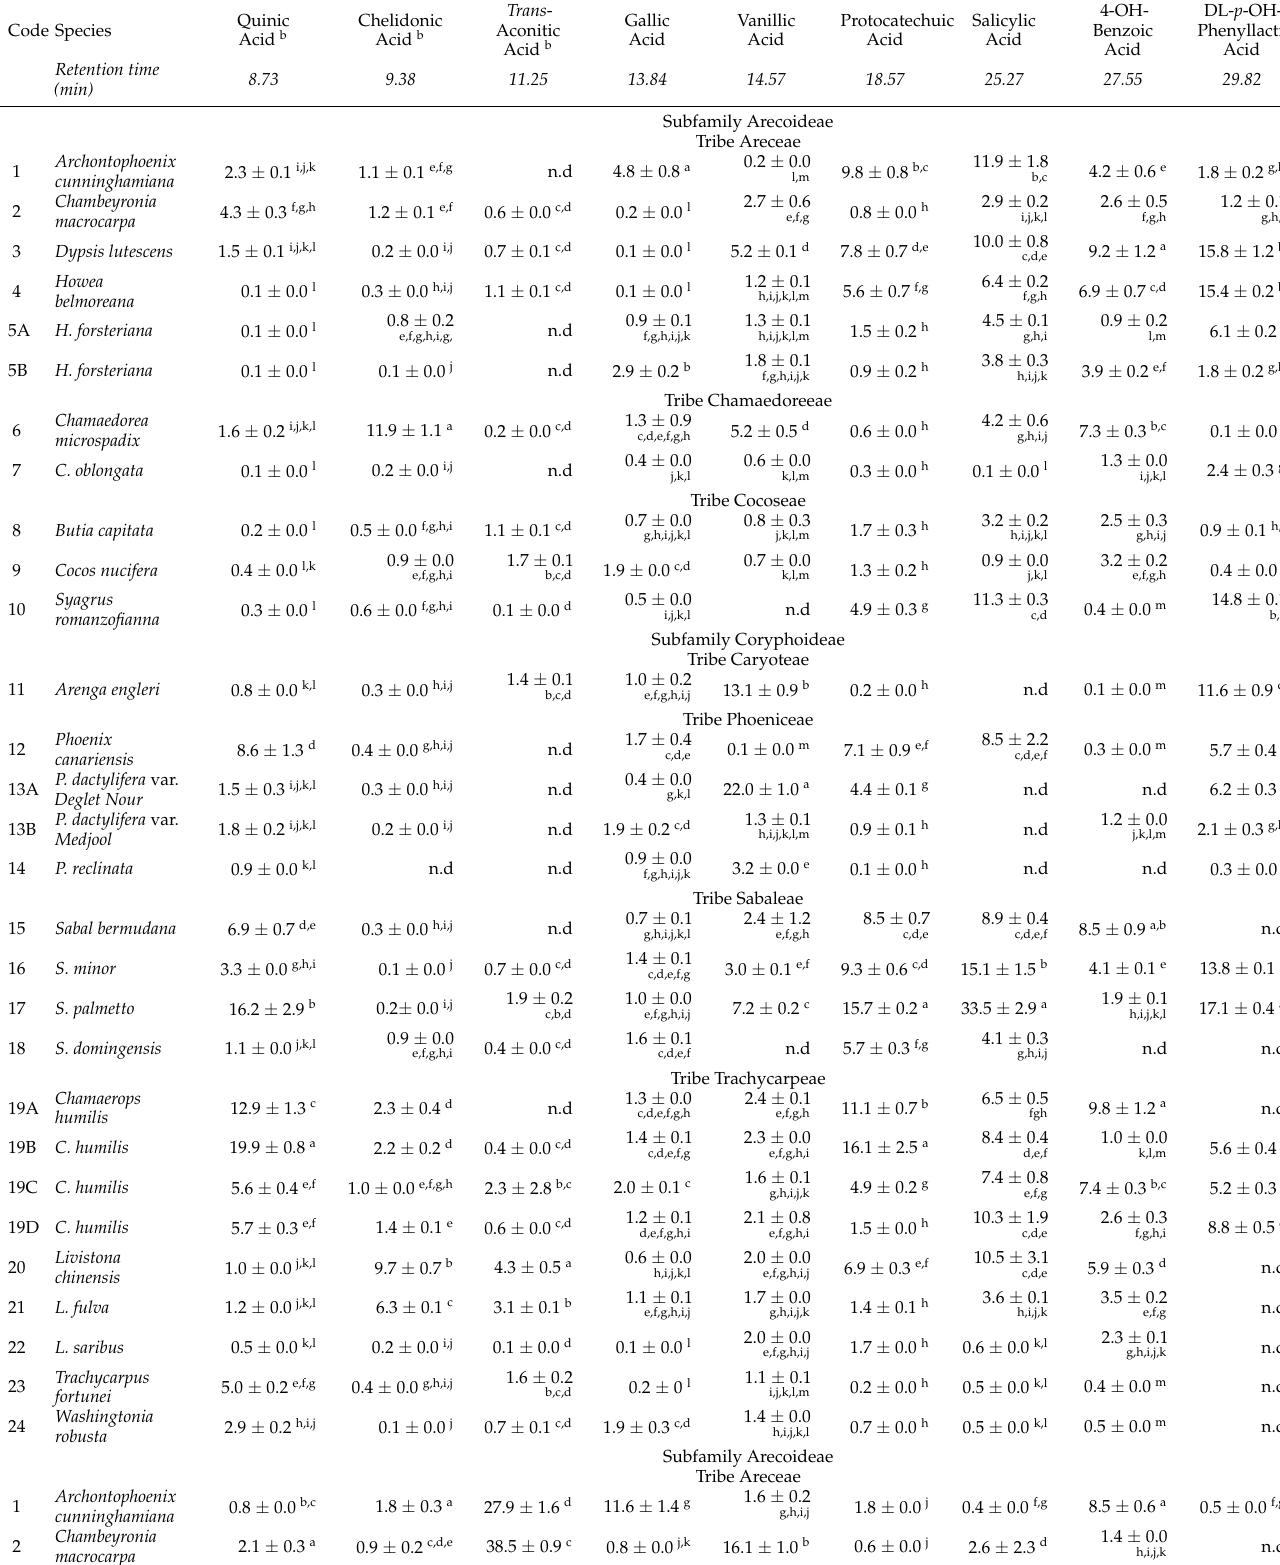
Table 2. Phenolic compound and organic acid (quinic, chelidonic, and trans -aconitic acids) profiles (mg/100 g dry weight) for seeds from Arecaceae species a